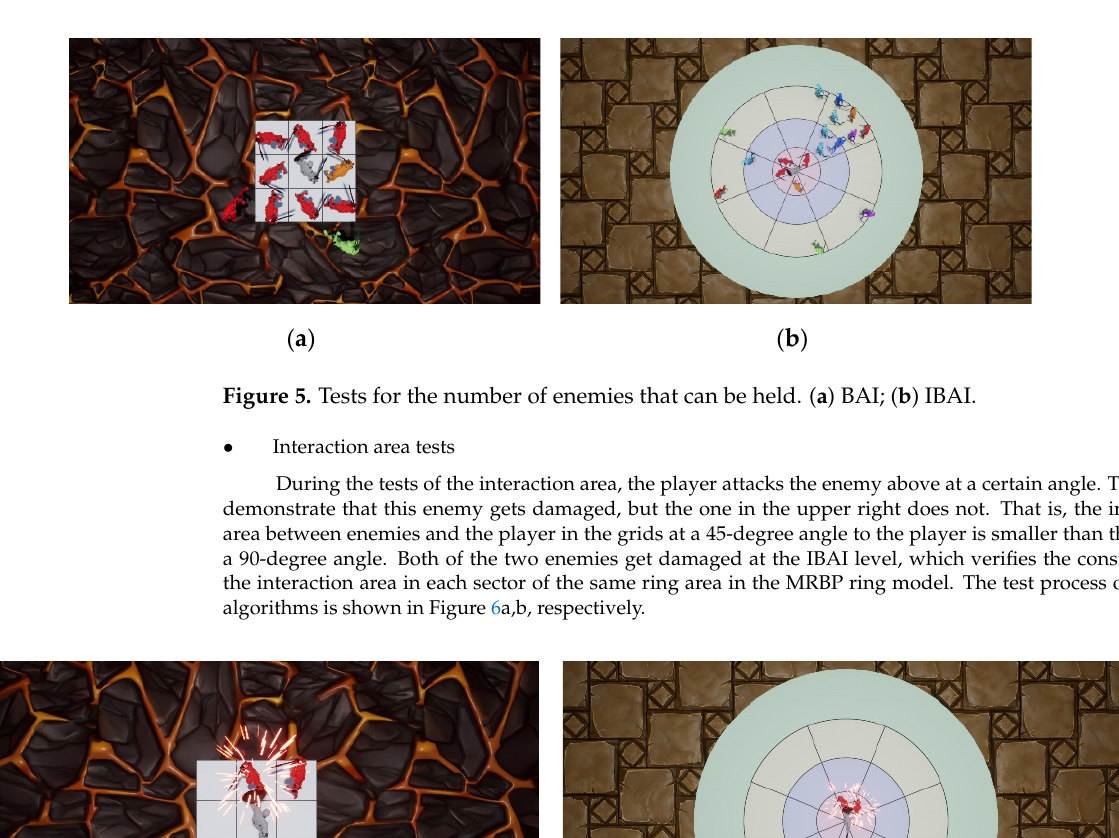
Figure 6. Tests for the interaction area between enemies and the player. ( a ) BAI; ( b ) IBAI.